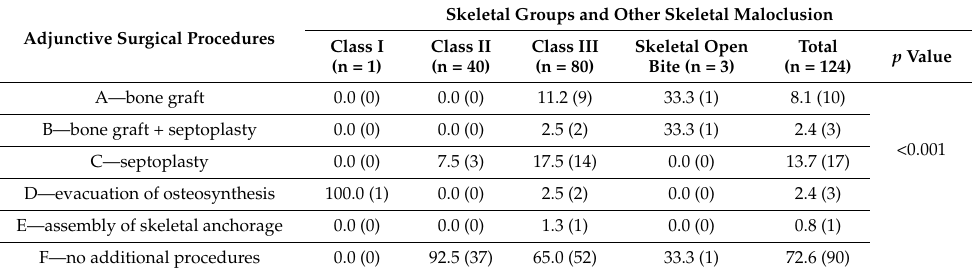
Table 9. The frequency of adjunctive procedures used during surgery (broken down into skeletal groups and skeletal open bite).